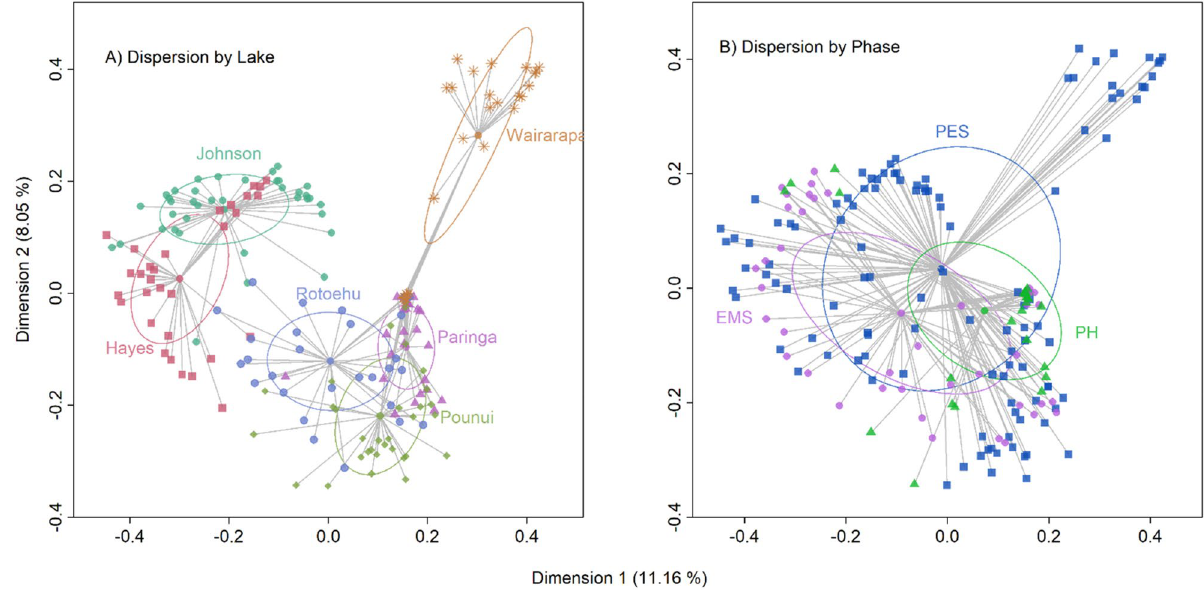
Figure 7. Principal coordinates analysis (PCoA) ordination plots of cyanobacterial communities based on Bray–Curtis dissimilarities for all six study lakes ( A ) and all phases ( B ). The ellipses indicate the mean distance from centroids, whereas the vectors show the distance to the centroid of each